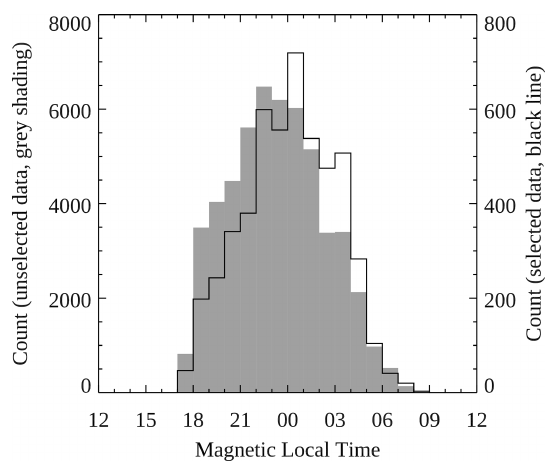
Figure 6. Histogram of the magnetic local time of the peak emis- sion height measurements. The black line shows selected data (blue height above 130km and at least 10km above the green height) us- ing the right ordinate axis, and the grey shading shows all remaining unselected data using the left ordinate axis.